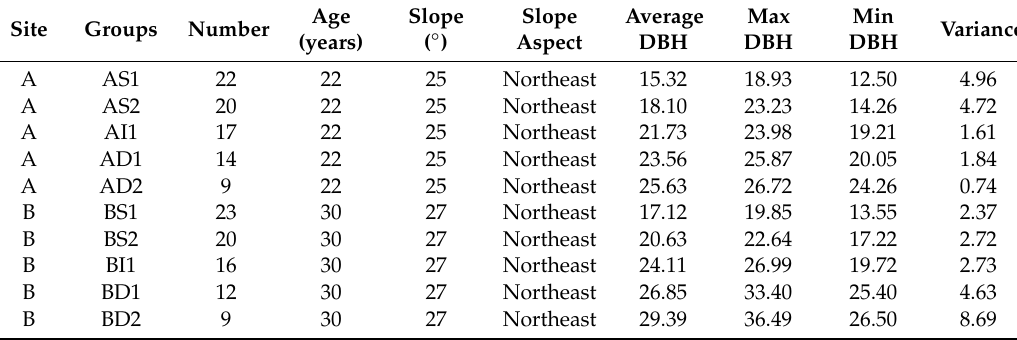
Table 1. Information of observed sample trees and monitoring sites.